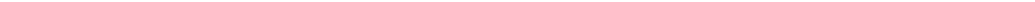
(see fi gure on previous page) Fig. 3 S/M/N/E- or RBD-speci fi c T-cell responses against WT SARS-CoV-2 ex vivo. a , d Representative fl ow cytometry plots in the I-I- δ , I-I- ο , M-M- ο , and I-I-I groups showing S/M/N/E- or RBD-speci fi c CD4 + T-cell responses (IFN- γ + ) ( a ) and CD8 + T-cell responses (IFN- γ + ) ( d ) against WT peptide pools of S/M/N/E and RBD. b , e Frequency and number of all S/M/N/E- or RBD-speci fi c CD4 + T cells ( b ) and CD8 + T cells ( e ) in the I-I- δ ( n = 25), I-I- ο ( n = 21), M-M- ο ( n = 9), and I-I-I ( n = 40) groups. The number in magenta indicates the mean in the frequency and number of detected responses. c , f S/M/N/E- or RBD-speci fi c CD4 + T cells ( c ) and CD8 + T cells ( f ) expressing IFN- γ and TNF are shown. Comparisons were performed using Mann – Whitney tests. Data in bar charts are shown as the means ± SEM and those in dot plots as the means ± interquartile range. Each dot represents one donor. * P < 0.05, ** P < 0.01.